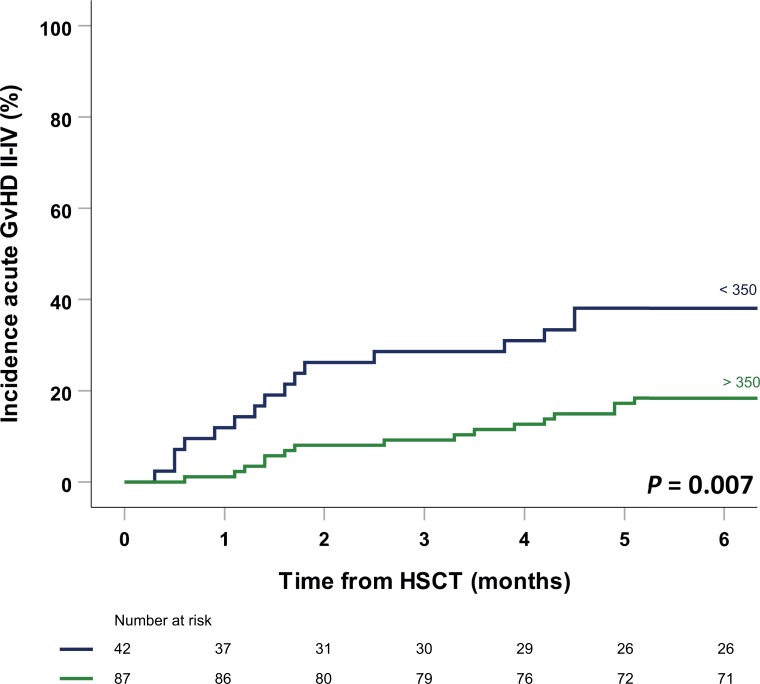
Cumulative prevalence of grade II-IV acute GvHD in patients with a trough CsA concentration <350 ng/mL (blue; N = 42) versus a trough CsA concentration ≥350 ng/mL (green; N = 87).